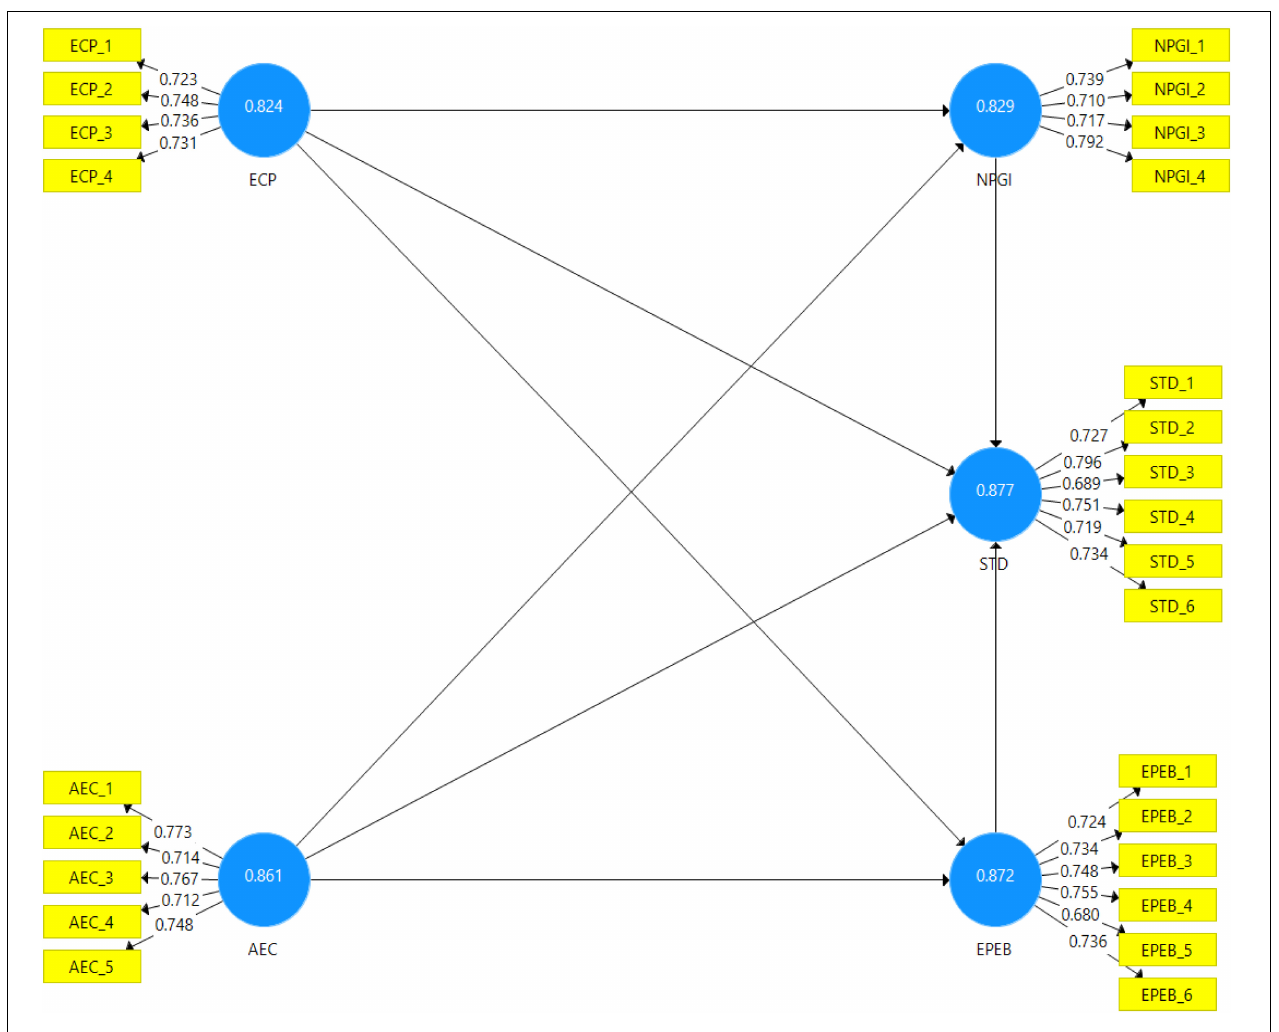
FIGURE 2 | Graphical representation of assessment of measurement model.